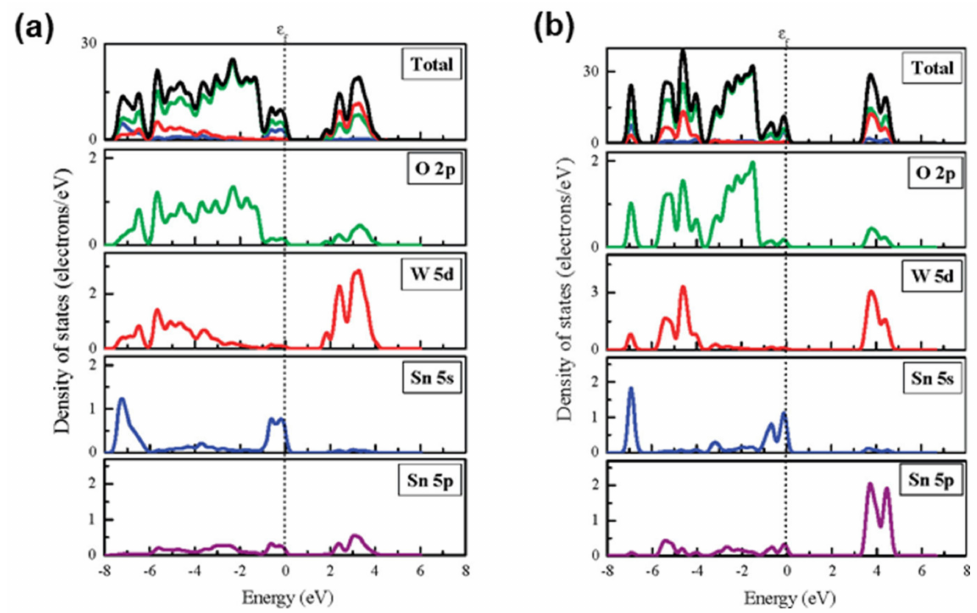
Figure 2. Partial density states of ( a ) α -SnWO 4 and ( b ) β -SnWO 4